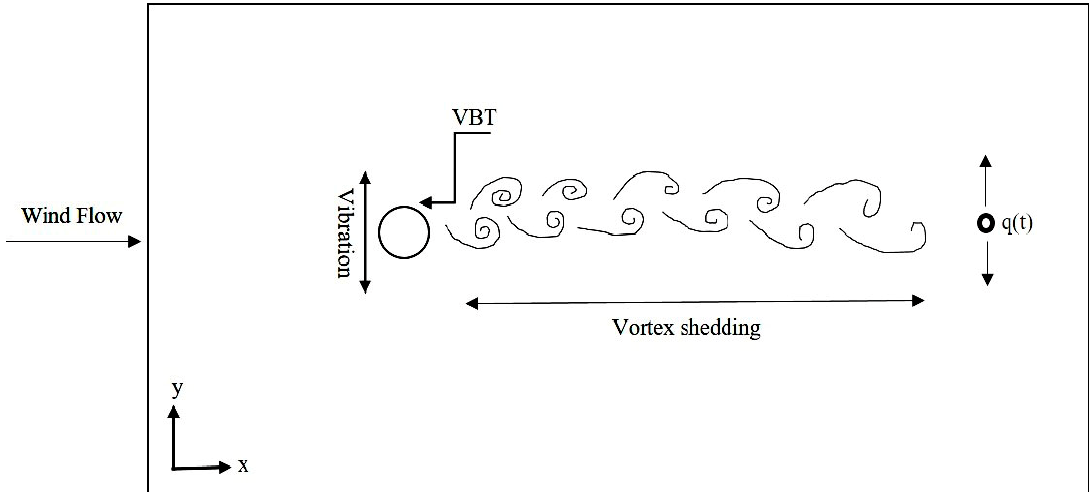
Figure 4. The schematic of the two-way effect of vortex-induced vibration. The vortex shedding caused by vibration is a phenomenon that occurs when fluid interacts with the vibrational structure, and it is a function of the Reynolds number. The coupled two equations of the VIV phenomenon are describing the effect of wind flow on the VBT structures, and vice versa, are as follows, according to [30].